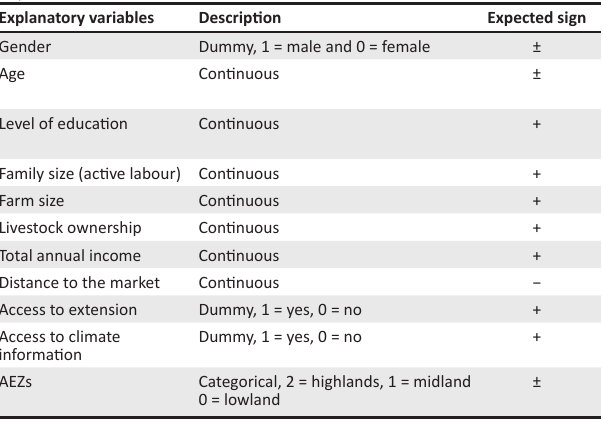
TABLE 1 : Description of independent variables and hypothesis for its effect on dependent